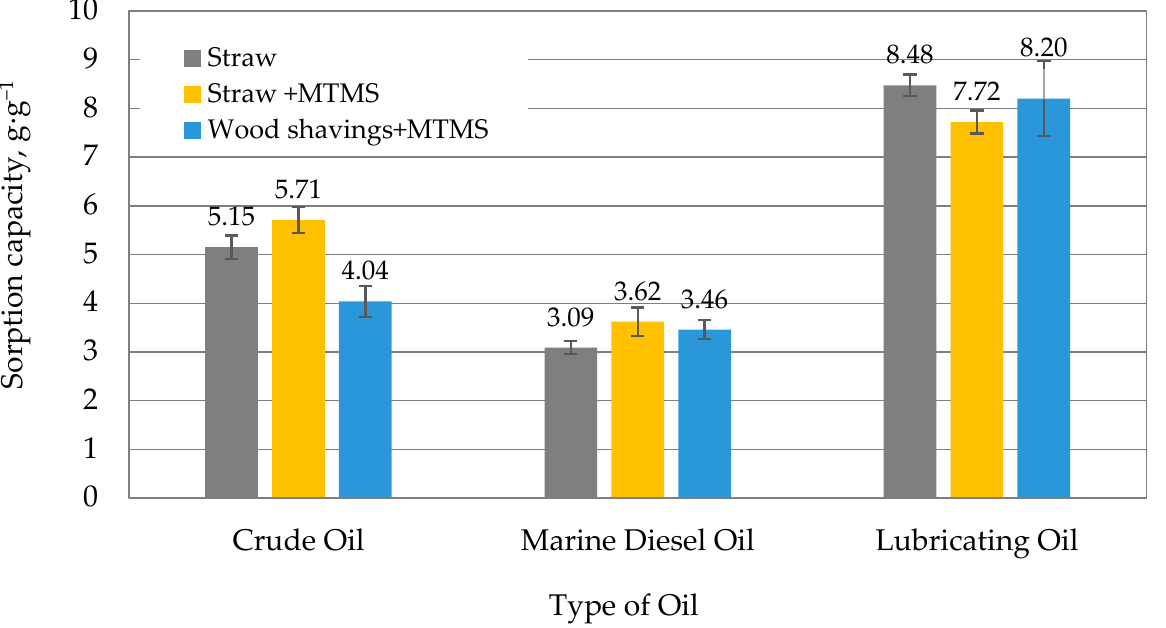
Figure 2. Comparison of the maximum sorption capacity of straw with and without MTMS treatment and MTMS treated wood shavings for crude oil, MDO and lubricating oil.